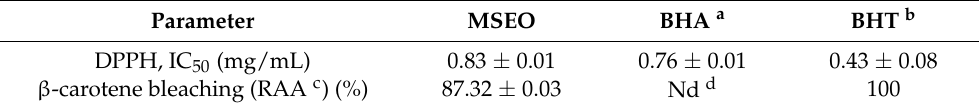
Table 3. Antioxidant activity of the essential oil of M. smithiana growing in western Romania. Parameter MSEO BHA a BHT b DPPH, IC 50 (mg/mL) 0.83 ± 0.01 87.32 ± 0.03